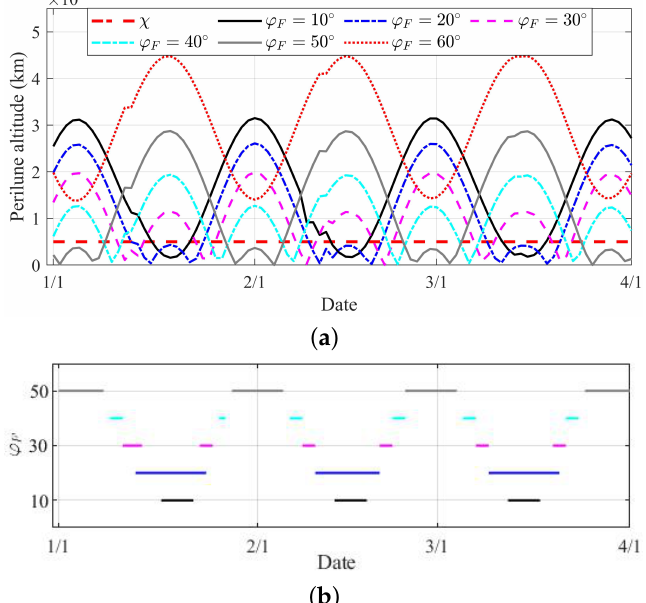
Figure 9. Opportunity distribution about several latitudes of landing field in the first three months of 2030. ( a ) Variation in the natural perilune altitudes at different latitudes; ( b ) Opportunity distribution for different